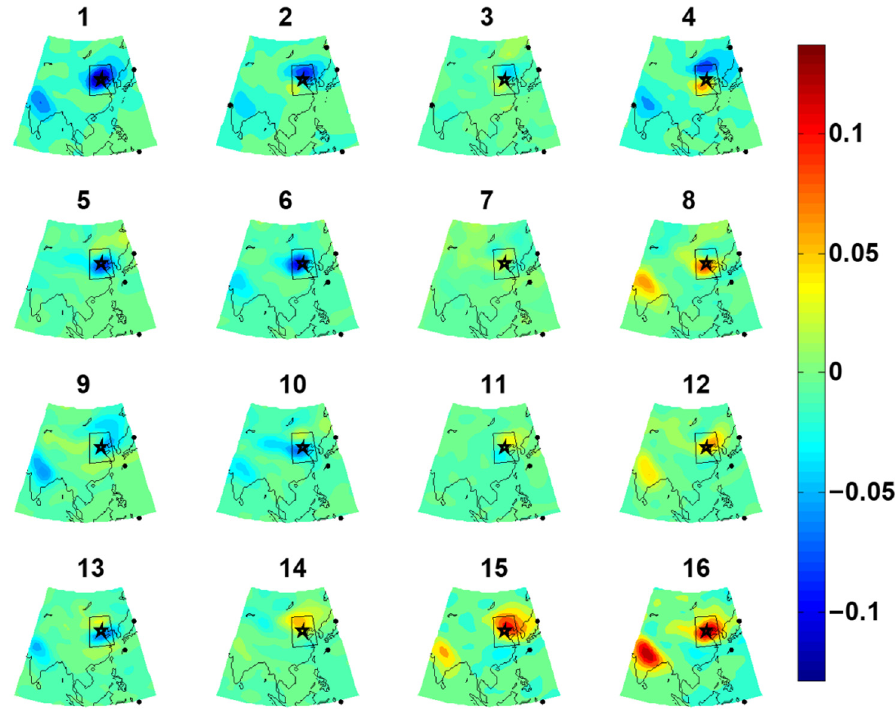
Figure 8. Distribution of vertical decreasing rate of temperature (°C/hm) for the 16 SOM nodes corresponding to the training results.